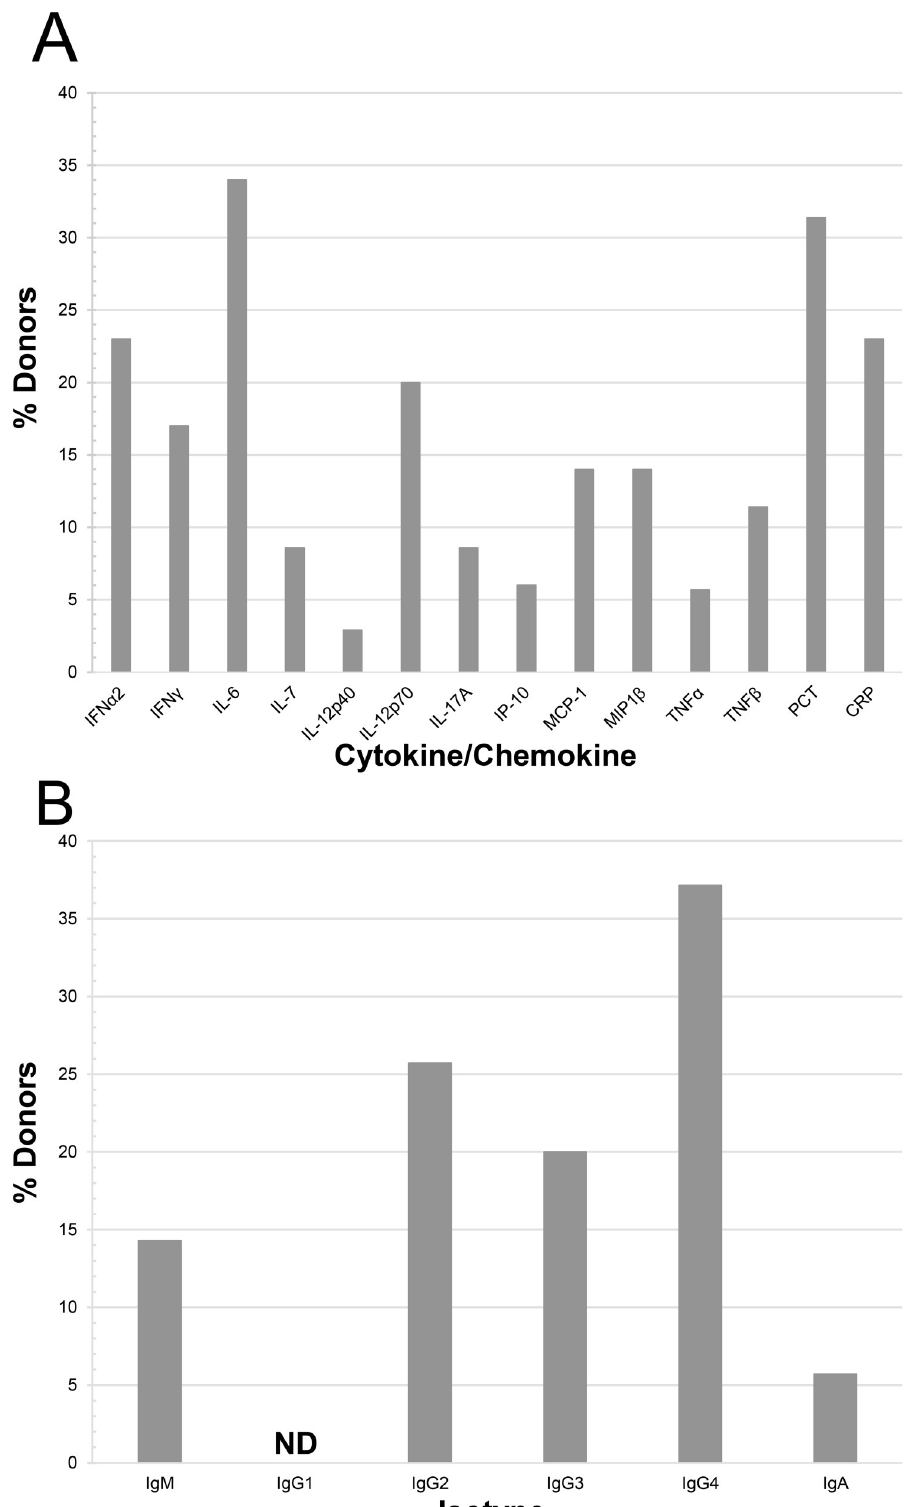
Fig 1. Composition of donor plasma samples. Donor plasma samples (n = 35) were analyzed for concentration of inflammatory cytokines/chemokines and Ig isotypes using multiplex immunoassays via the Luminex platform